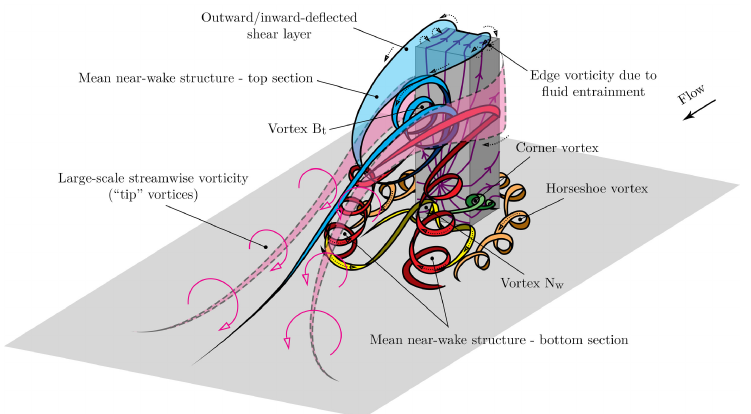
Figure 2. The time averaged wake model for a wall-mounted square cylinder from da Silva et al. (2020)